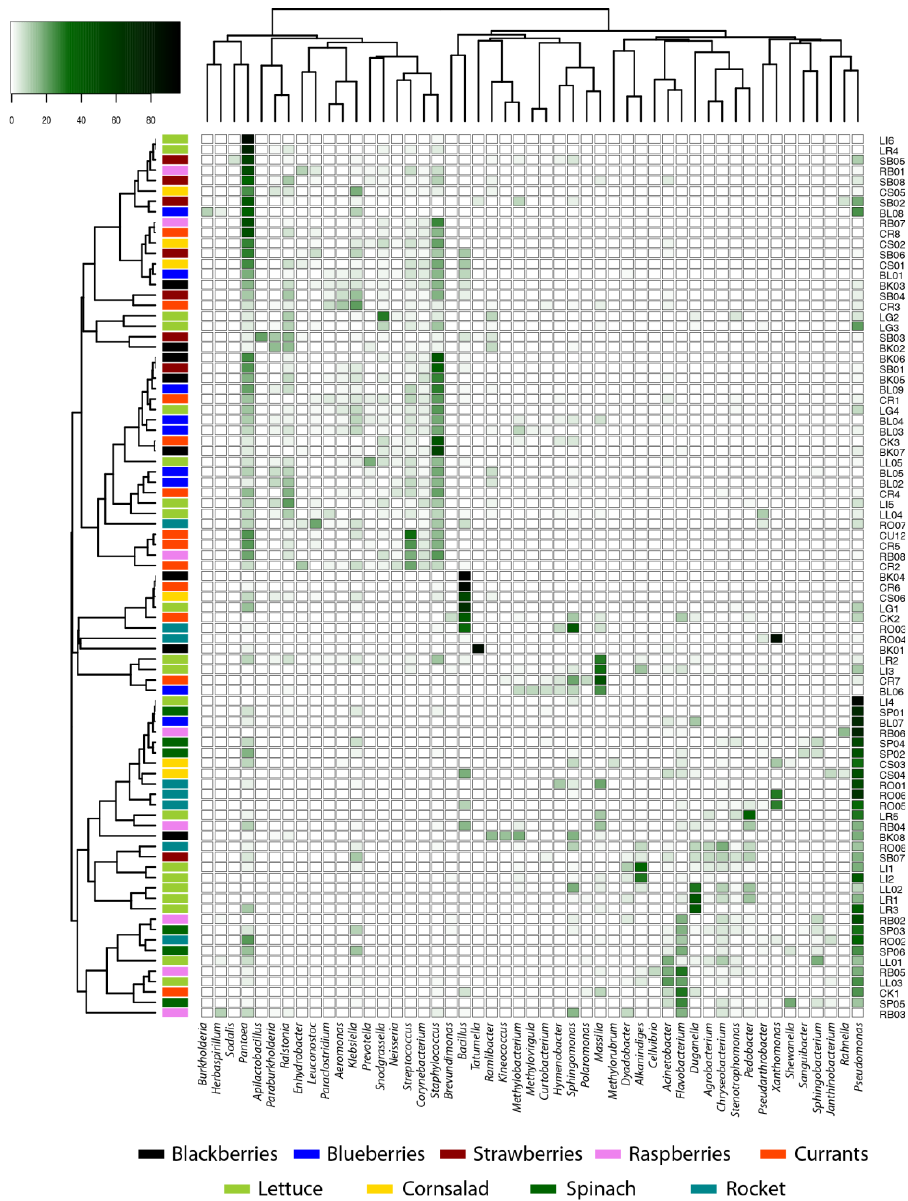
Figure 2. Heatmap of bacterial genera composition according to analysis of DNA extracted from fresh tissue samples of leafy vegetables and berry fruits. Only genera with min. 2% occurrences in any samples are listed. Dendrograms are based on occurrence of genera in samples (Bray-Curtis distance, complete clustering).